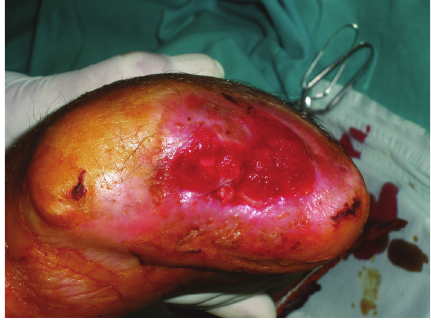
Figure 6: Forty days after injury: no signs of infection.